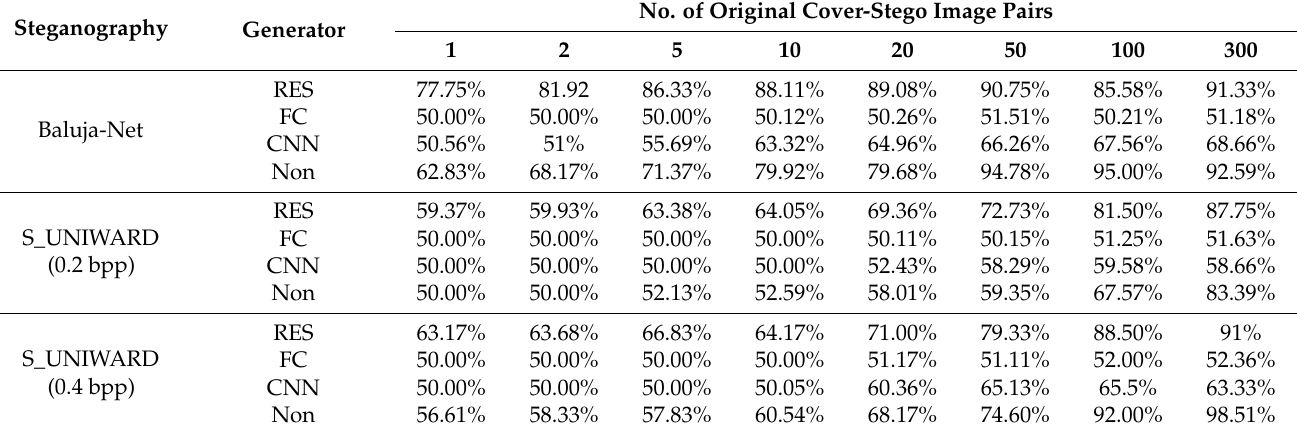
Table 2. Performance comparisons of proposed GLSNet with different generators and without